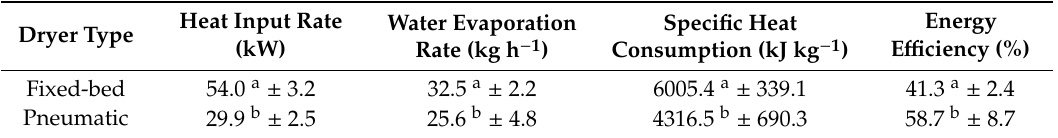
Table 3. Energy performance indices of a fixed-bed dryer and of a pneumatic dryer used to process cassava in